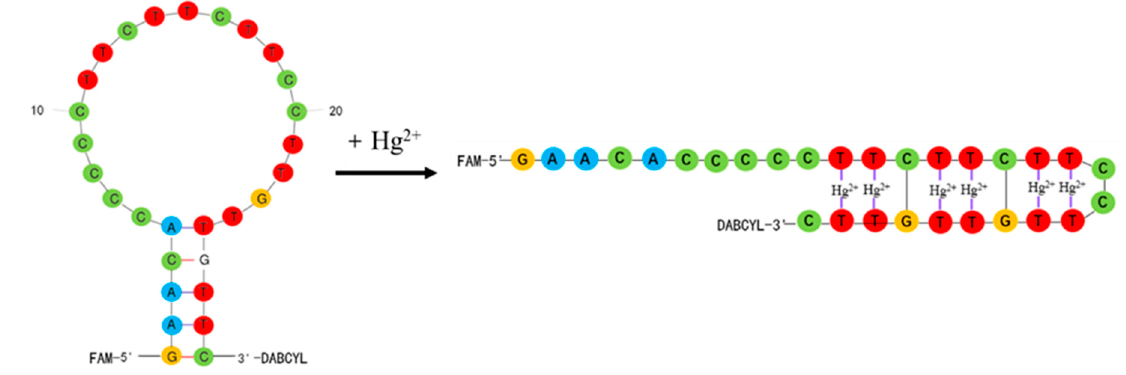
Figure 1. Principle of the molecular beacon aptamer detecting Hg 2+ .